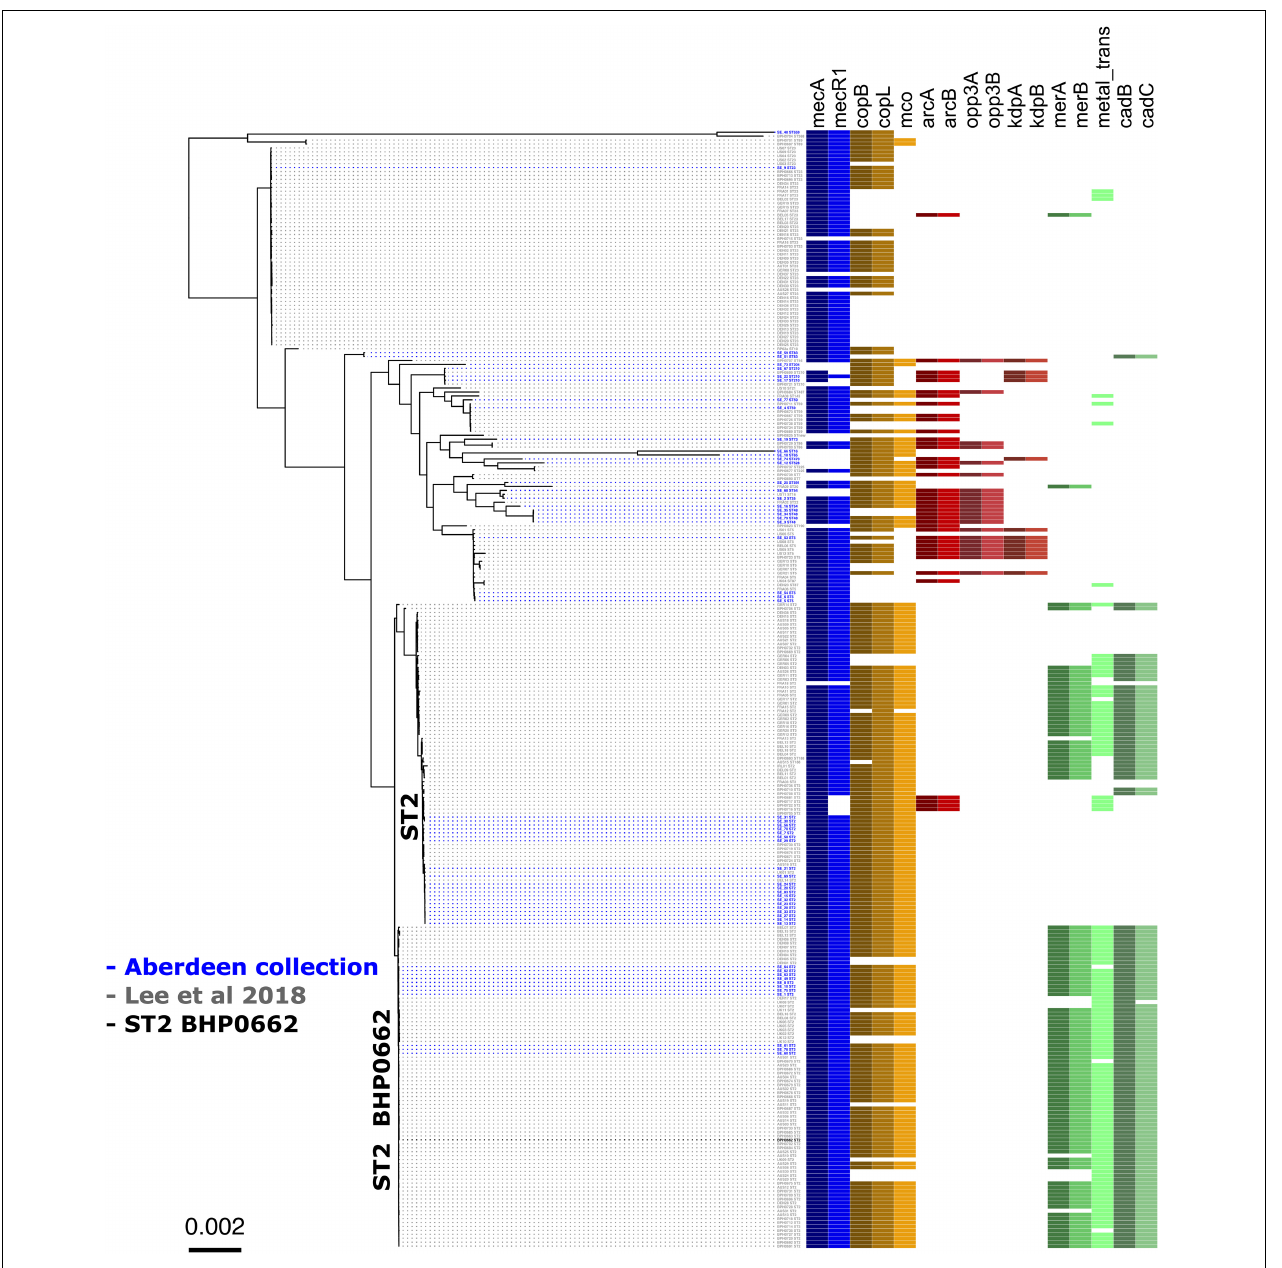
FIGURE 4 | Core genome phylogenetic tree of a world-wide collection of S. epidermidis genomes. Maximum likelihood tree of the 58 Scottish isolates ( Table 1 ) (isolates in blue) and the dataset from a world-wide collection of 225 isolates (isolates in gray) (NCBI BioProject numbers: PRJEB12090, PRJNA470534, and PRJNA470752) (Lee et al., 2018). As in Figure 1 , the tree is annotated with the isolate’s sequence type (ST) and displays the colored boxes of the heatmap illustrating the distribution of the characteristic genes of the SCCmec (blue), cop operon (brown/yellow), ACME (red) and COMER-like element (green) among the S. epidermidis isolates. Isolate BPH0662 (isolate in black) is used as reference strain in this phylogenetic